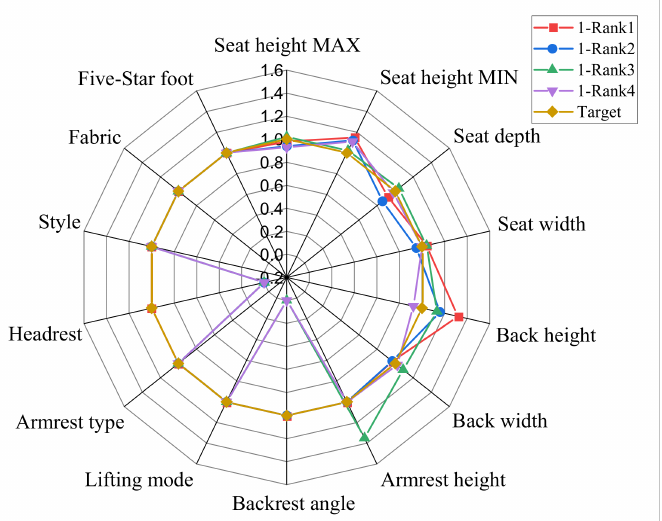
Figure 5. The results of K-NN office chair pattern retrieval.